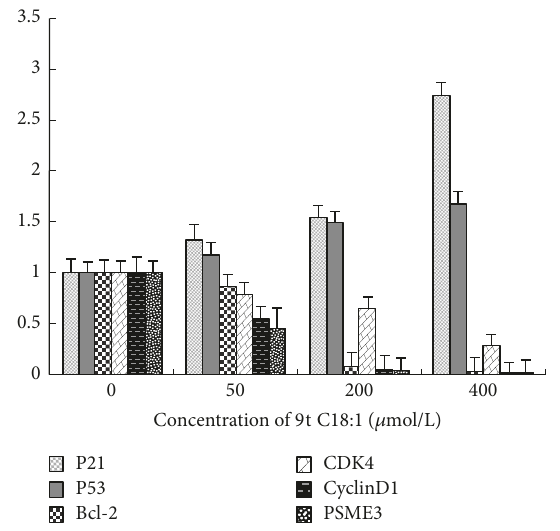
Figure 5: Effect of TFA on p21, p53, Bcl-2, CDK4, CyclinD1, and PSME3 mRNA expression in